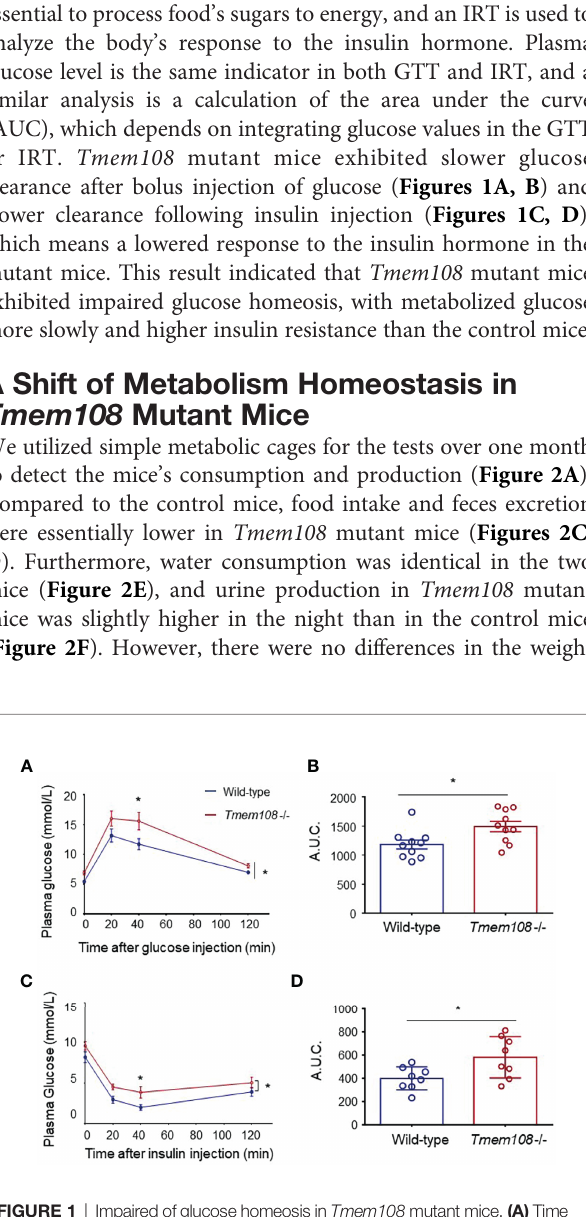
FIGURE 1 | Impairedofglucose homeosis in Tmem108 mutant mice. (A) Time courses of plasma glucose levelsafter overnight fastinginglucosetolerance test (GTT). Plasma glucose measuredin Tmem108 mutant ( Tmem108 -/-) mice was signi fi cantly higher than in control mice (wild-type).Glucose values innmol/L mean ± SEM at designated time points after glucose bolus injection at time point 0 (n = 10 per group,two-way ANOVA). (B) AUC (area under the curve) for plasm glucose (0 – 120 min)was calculated duringthe GTT (unpaired t -test). (C) Time courses of plasma glucose levelsafter 4-hourfasting in insulin resistance test (IRT). Plasma glucose measured in Tmem108 mutant mice was signi fi cantly higher than in control mice. Glucose values are means± SEM at designated time points after insulin injection at time point 0 (n = 8 per group, two-way ANOVA). (D) AUC for plasm glucose (0 – 120 min)was calculatedduringthe IRT (unpaired t - test). (*p <